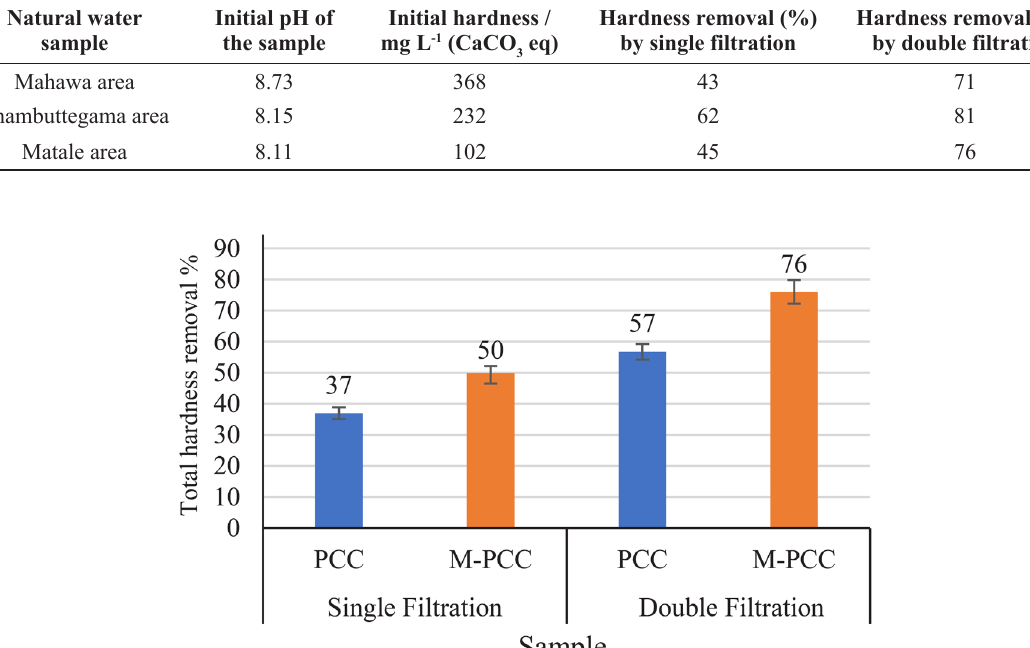
Table 2: Initial pH and % hardness removal by M-PCC in single and double filtrations. Natural water sample